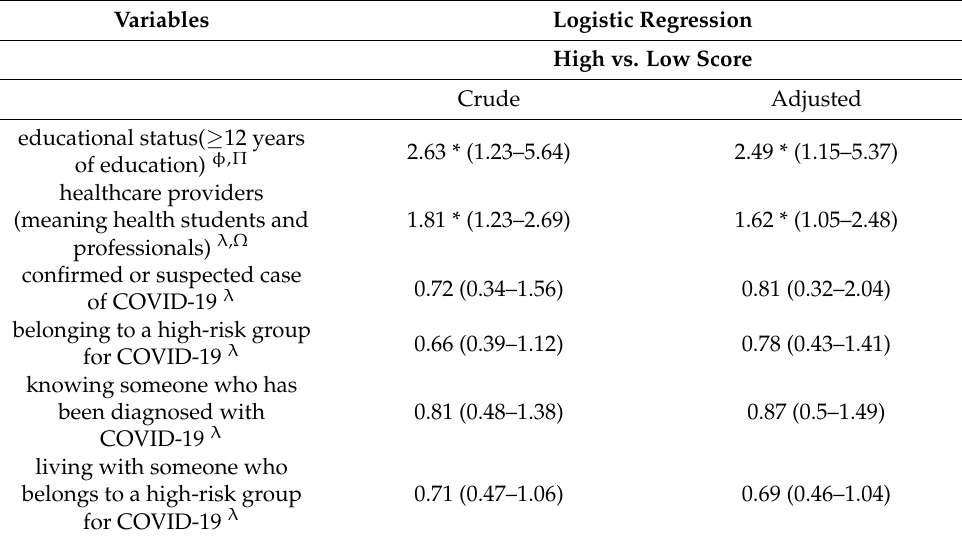
Table 3. Crude and adjusted ** odds ratios between sociodemographic, associated factors, and knowledge about COVID-19 regarding the 440 Brazilian